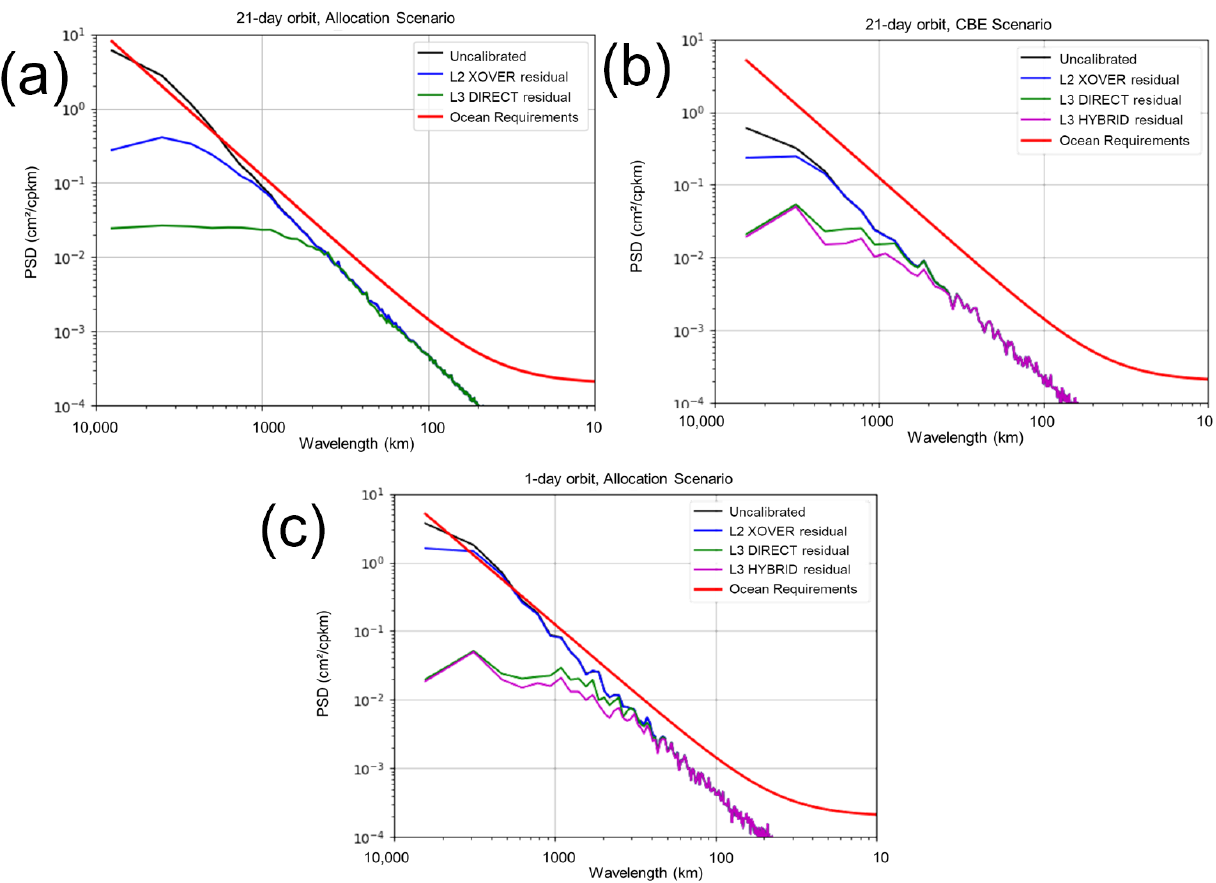
Figure 17. Power spectral density (PSD) of the requirements (red), uncalibrated (black) and calibrated (blue for Level-2, and green/purple for the Level-3) errors over the ocean. Panel ( a ) is for the 21-day orbit and the ‘spectral allocation scenarios’. Panel ( b ) is for the 21-day orbit and the CBE21 scenario. Panel ( c ) is for the one-day orbit and the ‘spectral allocation scenarios’.